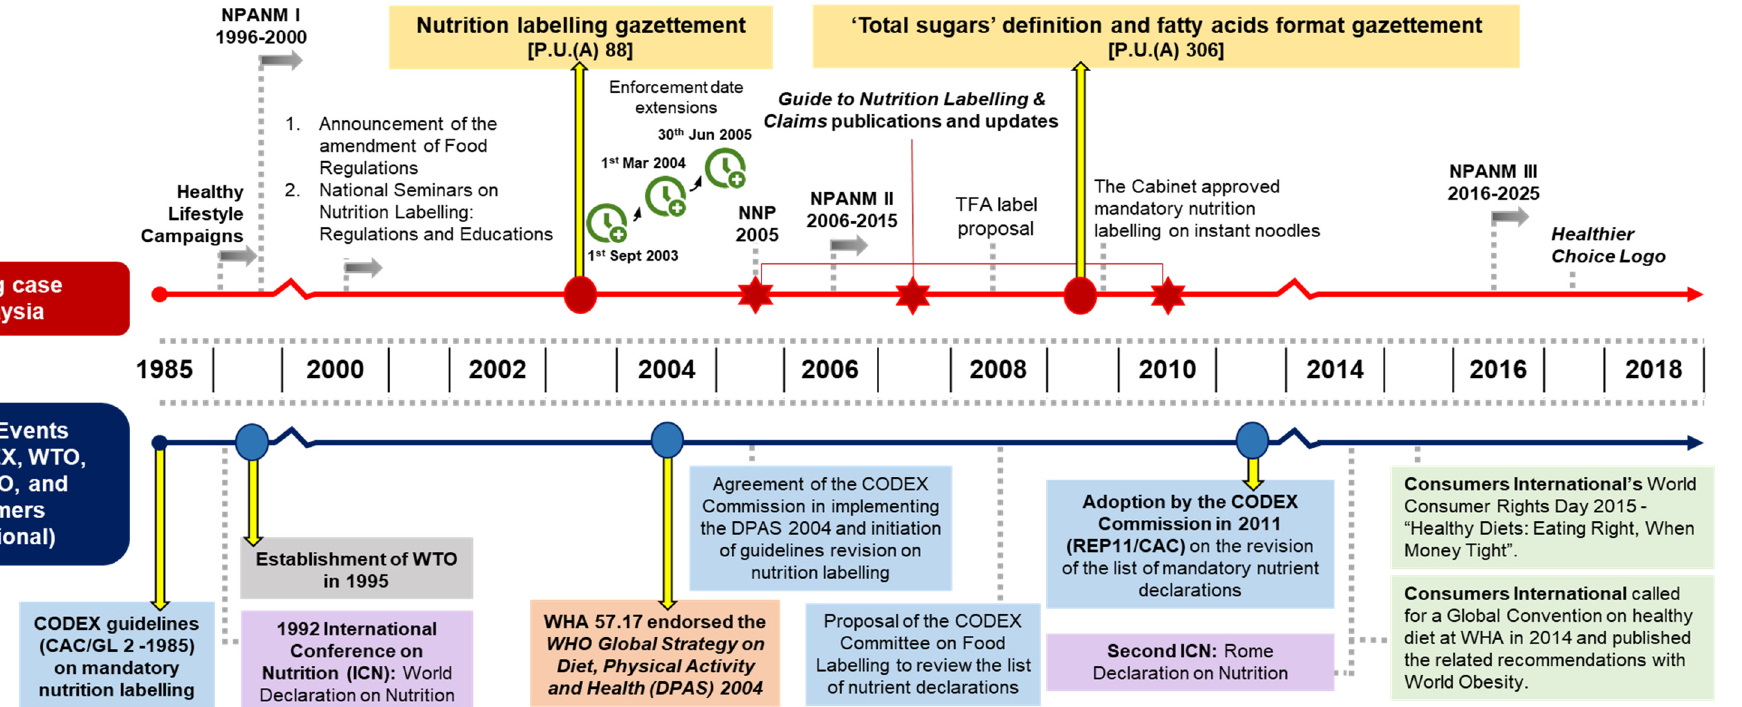
Figure 1. Historical mapping of mandatory nutrition labelling in Malaysia Abbreviations: DPAS = WHO Global Strategy on Diet, Physical Activity and Health; FAO = Food and Agriculture Organization; ICN = International Conference on Nutrition; NNP = National Nutrition Policy of Malaysia; NPANM = National Plan of Action for Nutrition of Malaysia; TFA = trans fatty acids; WHA = World Health Assembly; WHO = World Health Organization; WTO = World Trade Organization.